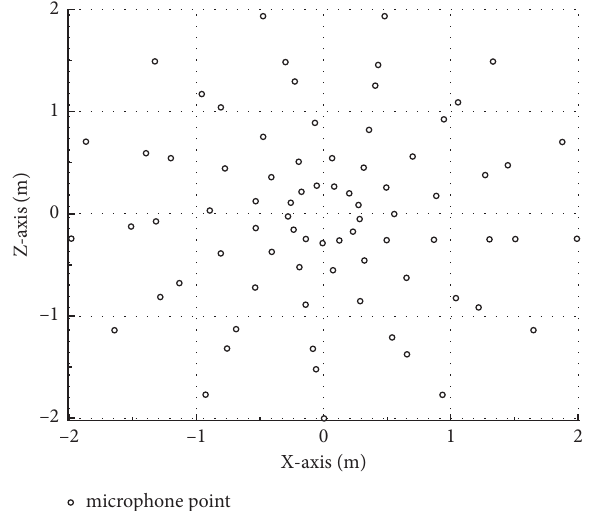
Figure 3: The dynamic ranges of the used array in frequency